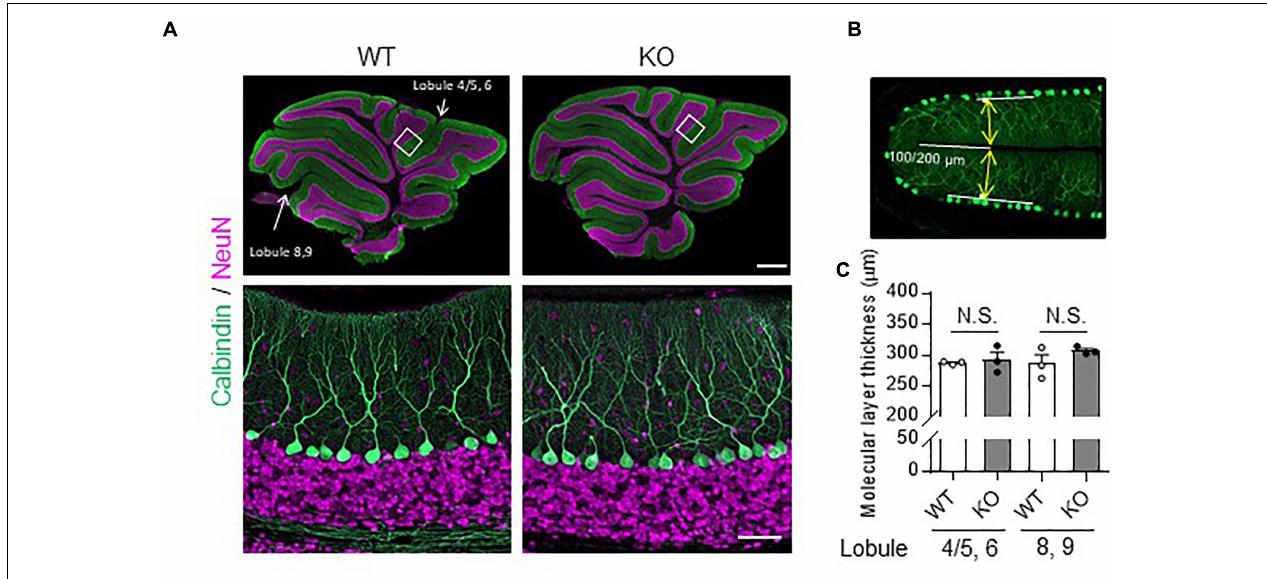
FIGURE 1 | No obvious morphological differences in the cerebellum were found between TRH-KO mice and their WT littermates. Immunohistochemistry was used to compare sagittal cerebellar sections from TRH-KO mice to those from their WT littermates. Slices were double-immunostained for calbindin, a marker of PCs (green), and NeuN, a marker of granule cells (magenta). (A) Sagittal sections of the WT (left) and TRH-KO (right) cerebellum. The boxed areas in upper panels are enlarged. Scale bar: 500 µ m (upper right) and 50 µ m (lower right). KO, knock-out; WT, wild-type. (B,C) Quantitative analysis of the molecular layer thickness. The molecular layer thickness was measured at two different points on the sagittal section of the cerebellar vermis: lobule 4/5 and lobule 6 at 100 µ m from the end of the primary fissure, and lobule 8 and lobule 9 at 200 µ m from the end of the secondary fissure (B) . The molecular layer thickness of both sides of the fissure was measured, and the sum was defined as molecular layer thickness. There are no significant differences at both two points between genotypes (C) . KO, knock-out; N.S., not significant; WT,